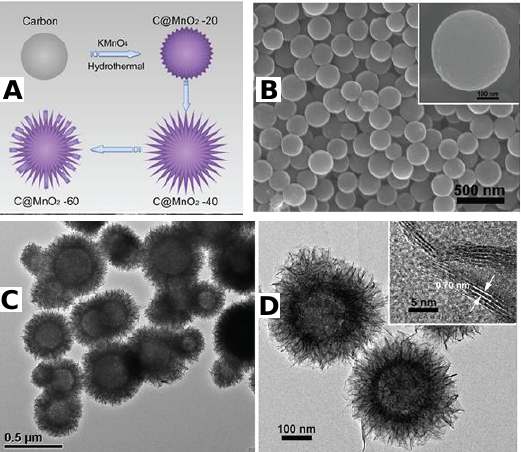
Figure 6. ( A ) Schematic illustration of the fabrication process of the carbon@MnO 2 nanospheres. ( B ) SEM images of bare carbon nanospheres. ( C , D ) Typical TEM images of carbon@MnO 2 at different magnifications; inset of ( D ) is the HRTEM image of a MnO 2 nanosheet. Reproduced with permission from [74]. Copyright © 2014, Elsevier B.V.